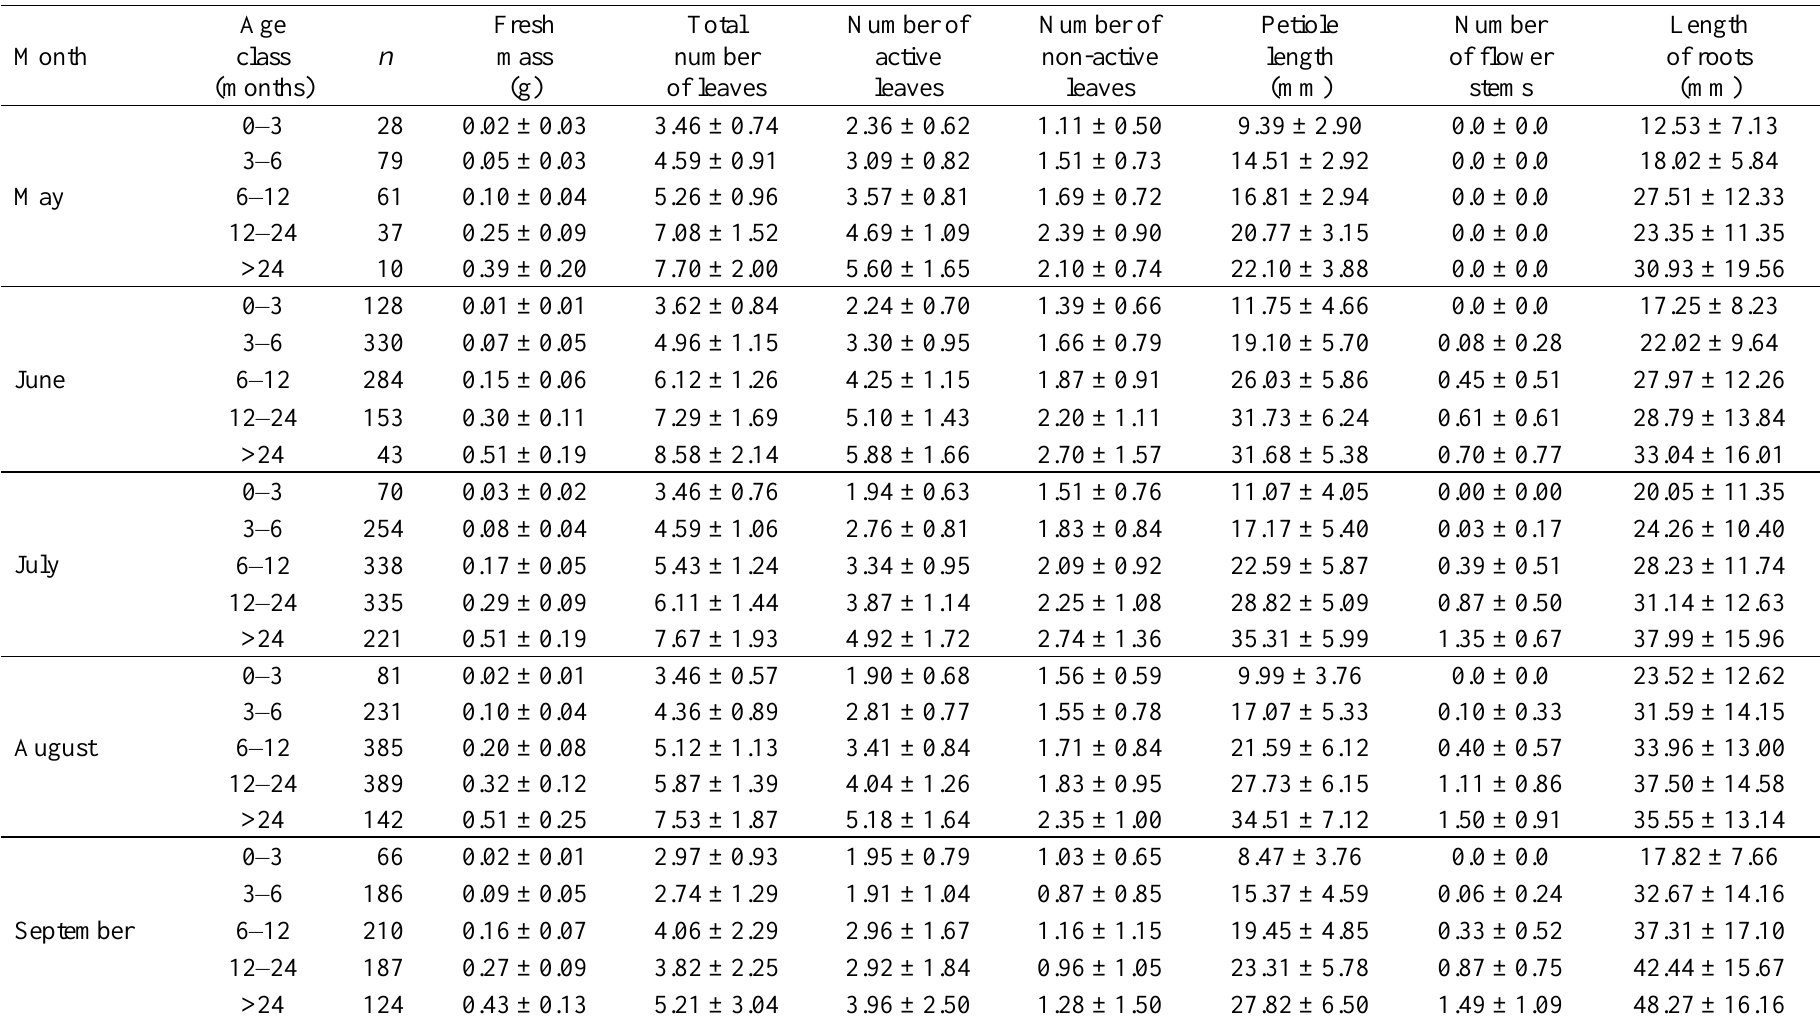
Table A1. Morphological features of Drosera rotundifolia growing in 2013 and 2014 on the Sphagnum palustre field; mean values ± SD (standard deviation). n = number of individual